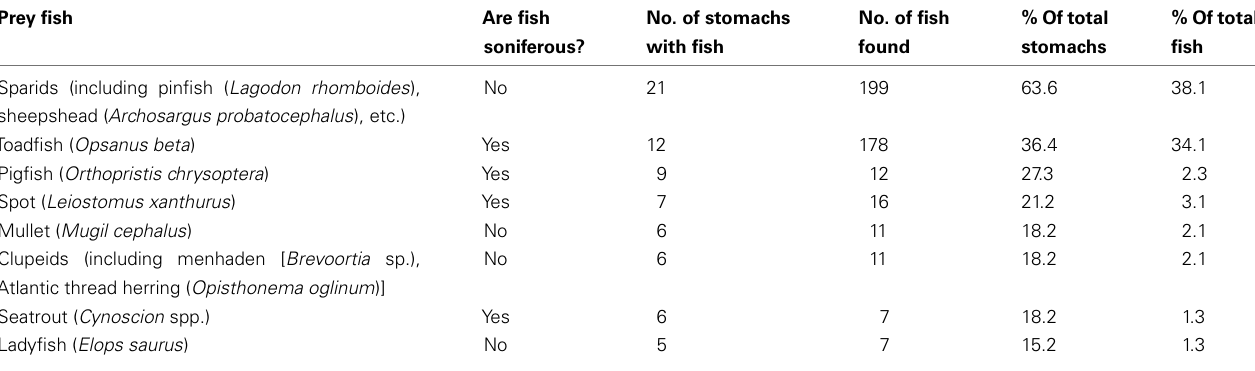
No. of stomachs No. of fish % Of total % Of total soniferous? with fish found stomachs fish